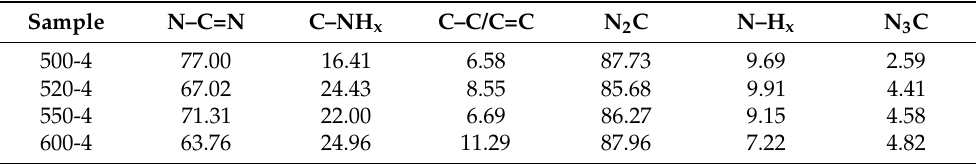
Table 3. Chemical composition of 500-4, 520-4, 550-4, and 600-4 calculated from peak fitting procedure applied to N 1s and C 1s spectra of